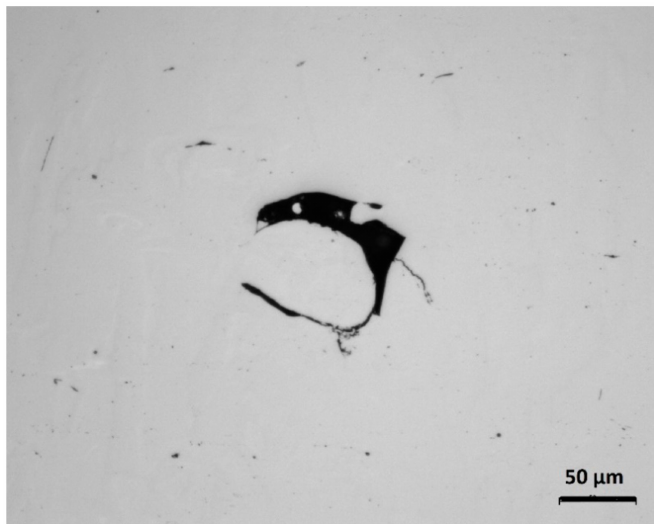
Figure 11. Micrograph of Sample 22 showing a crack (indicated by the arrow) initiated at the edge of a lack of fusion